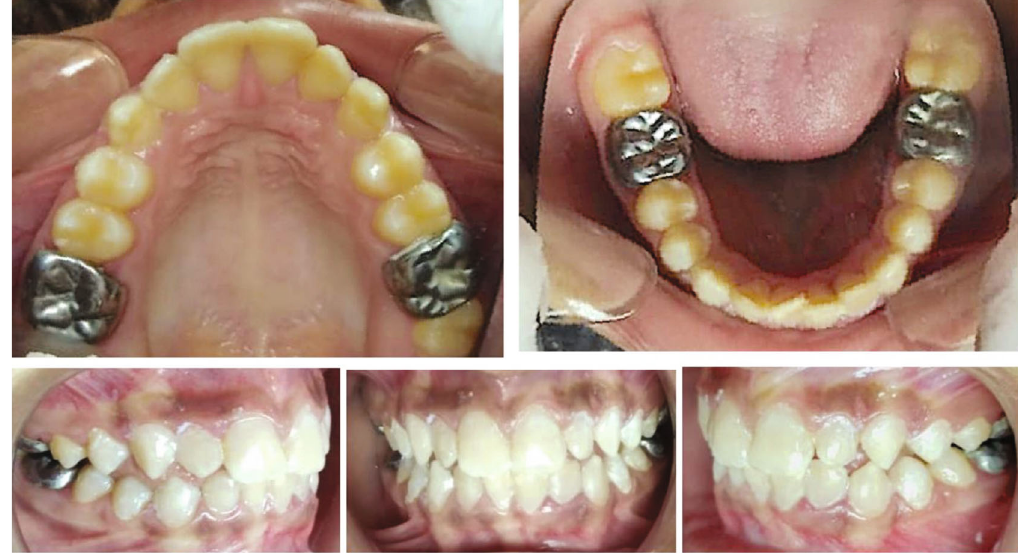
Figure 2: Postoperative intraoral